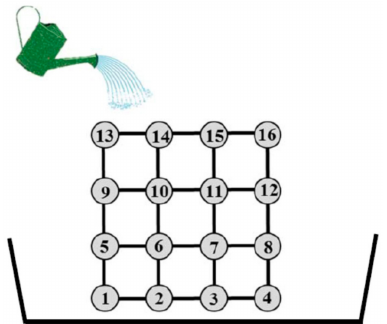
Figure 7. Schematic diagram of the electrode configuration used in the measurements presented in Figures 8–10. Water was applied predominantly in the area above electrode #13. A water barrier (container) was placed below the lowest row of electrodes (#1–#4) to demonstrate measurements of high moisture concentration.